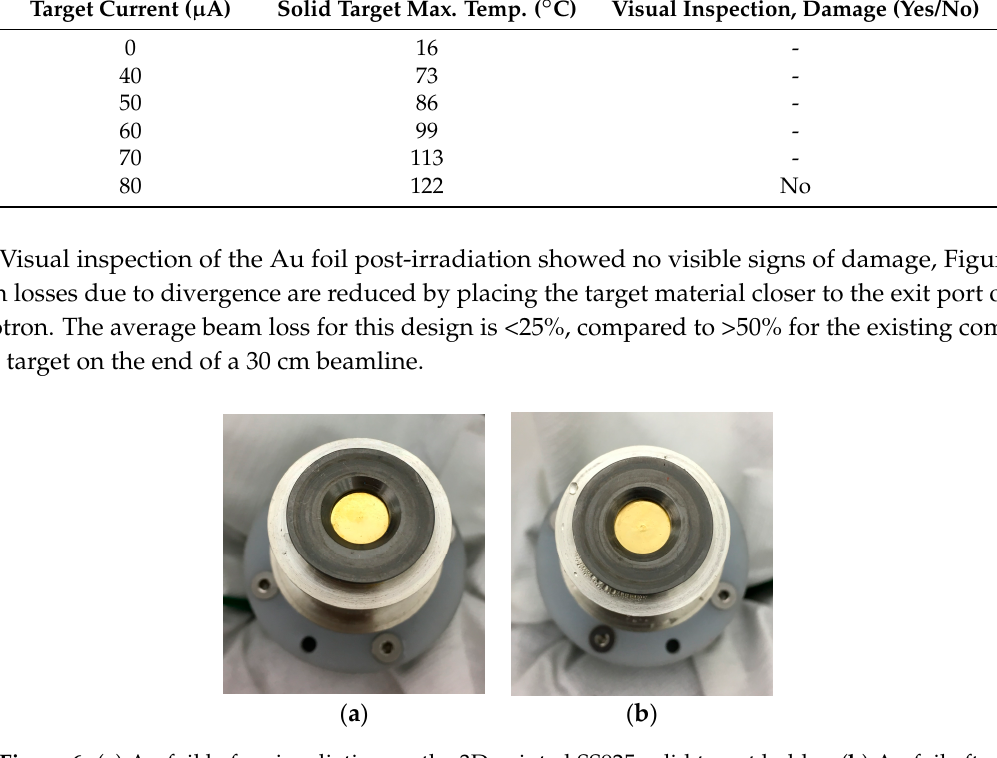
Figure 6. ( a ) Au foil before irradiation on the 3D-printed SS925 solid target holder. ( b ) Au foil after being subjected to experimental protocol as described above.